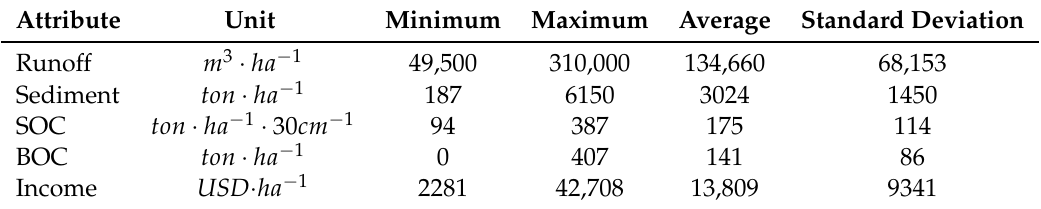
Table 2. Statistical indicators for the cumulative performance values over 30 years of all considered land use trajectories corresponding to the sample land unit.